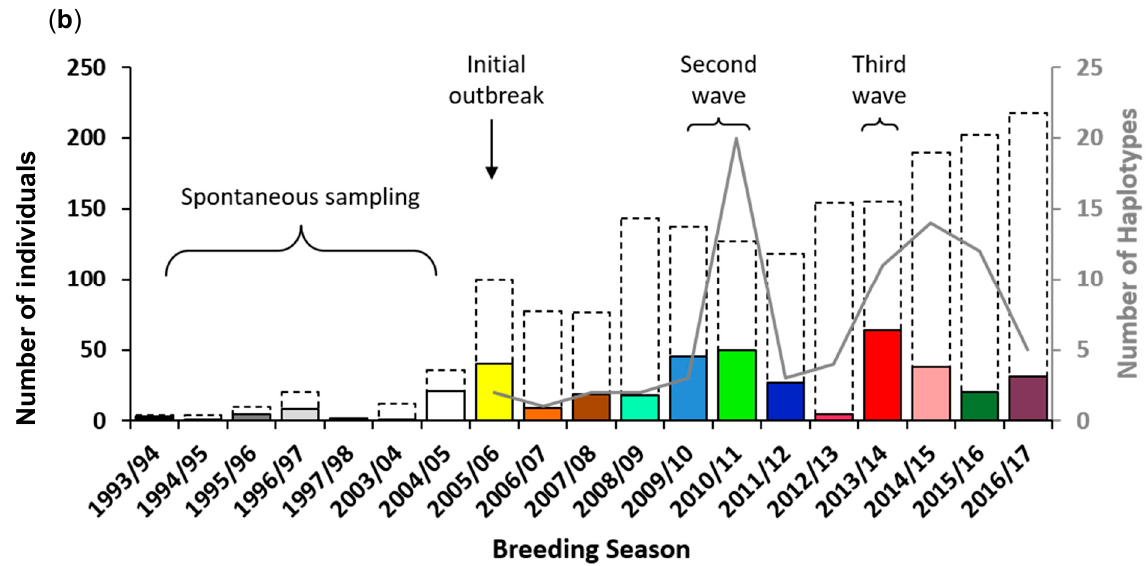
Figure 3. ( a , top ) Haplotype network displaying the diversity and evolution of BFDV Rep haplotypes in Mauritius parakeet hosts. The size of each circle is proportional to the number of individuals sharing that viral haplotype and the length of the lines between circles are proportional to the number of base pair changes between each haplotype. ( b , bottom ) Number of individuals screened (dashed bars), viral prevalence (solid bars), and number of haplotypes (grey line) detected from 1993 to 2017. Color codes in 3a refer to the sampling year shown in 3b. The screening dataset from 2005 to 2017 comprises a systematic sampling of fledglings.